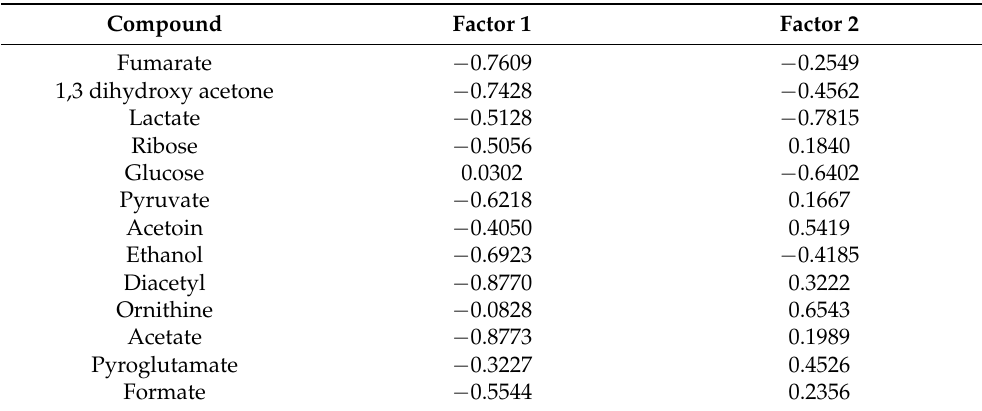
Table 4. Factor loadings of the first two factors of PCA (accounting for about 56% of the total variability). Compound Factor 1 Factor 2 Fumarate −